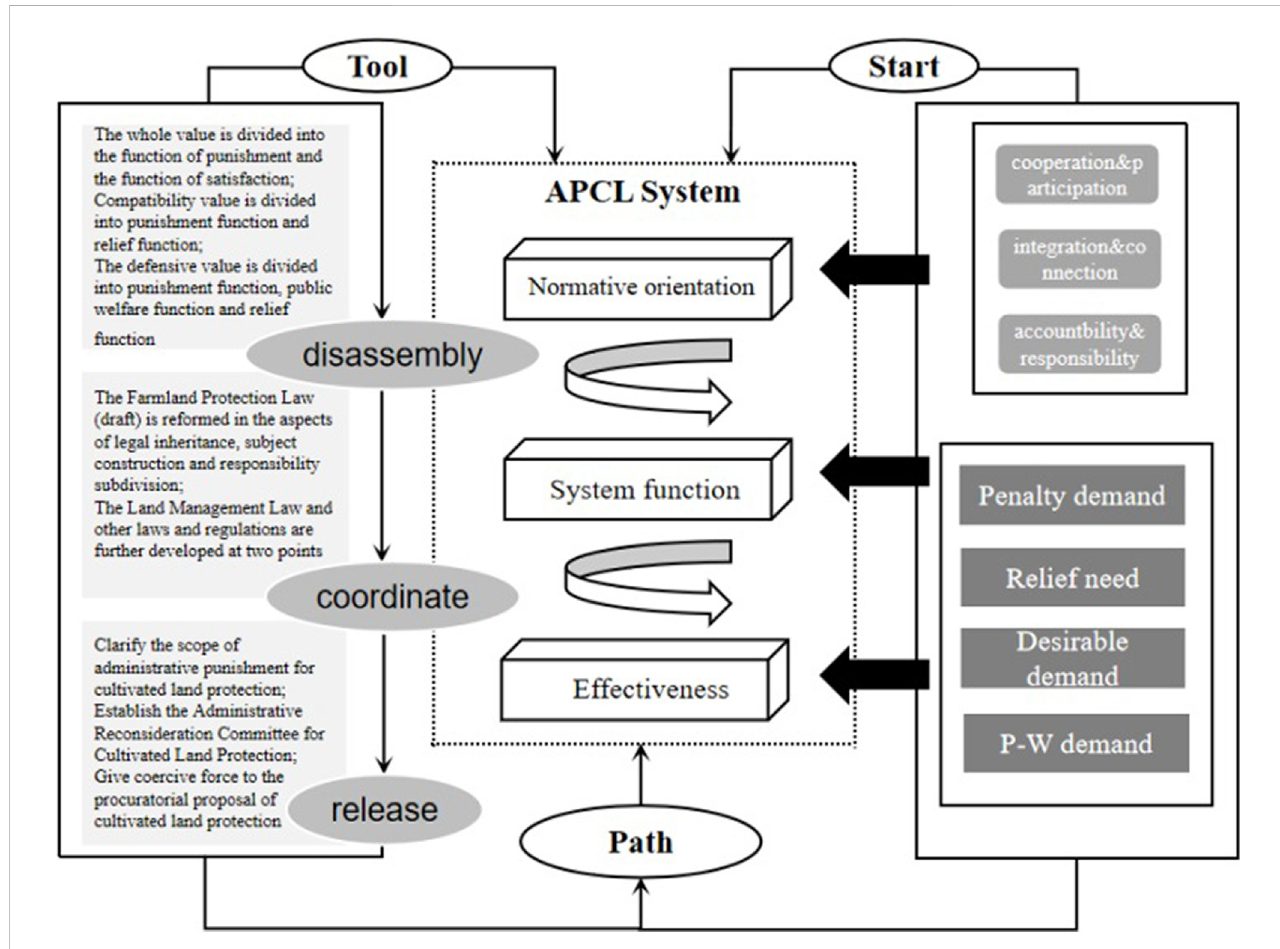
FIGURE 4 Path Map for Achieving the legitimacy of cultivated land administrative